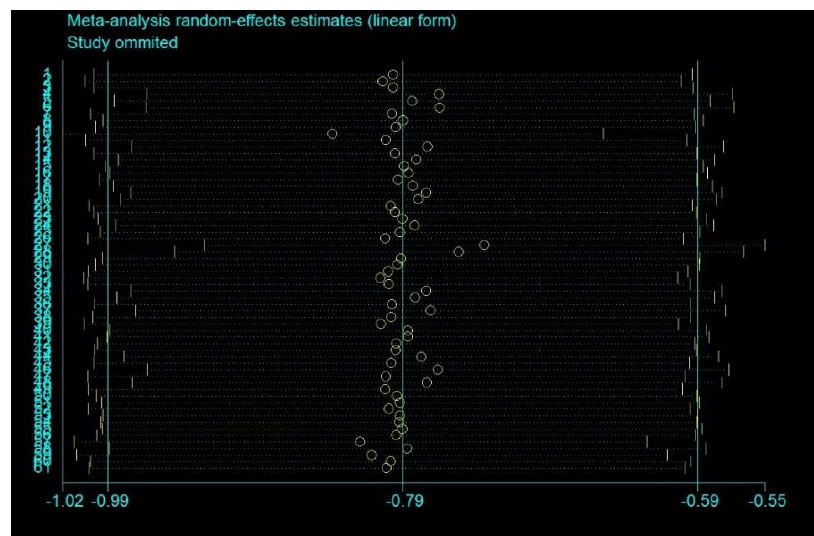
Figure 4. Meta-analysis random effects estimates (linear form). Note: The vertical coordinate is the included studies, and the horizontal coordinate is the confidence interval limit.